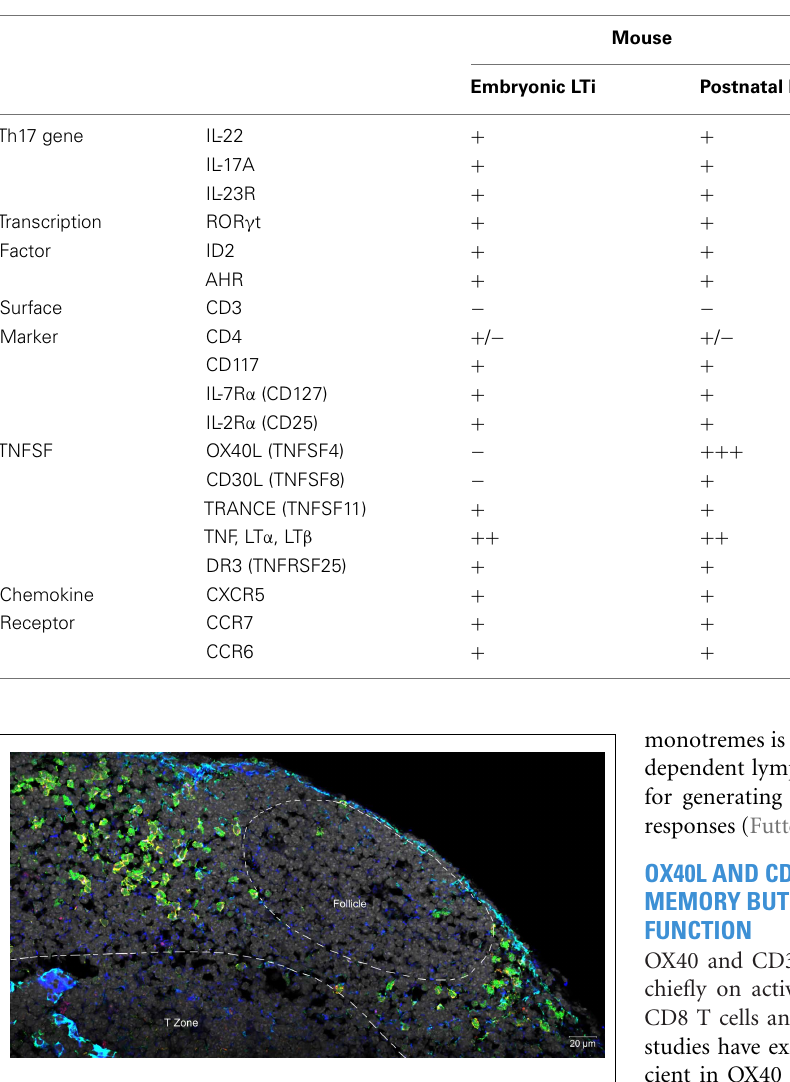
FIGURE 1 | Confocal micrograph of mouse mesenteric lymph node, showing the localization of LTi at the margins of follicles and in association with the stromal element MadCAM. Normal lymph node sections were stained with fluorescent markers for Ror γ t (green), IL-7R α (Yellow), MadCAM-1 (blue, turquoise), and cell nuclei